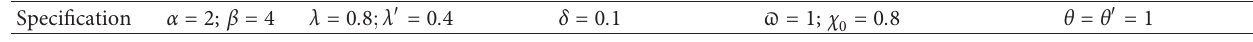
( C n , C n ,P n ) under different λ ′ r,p r,e r,fp Ψ